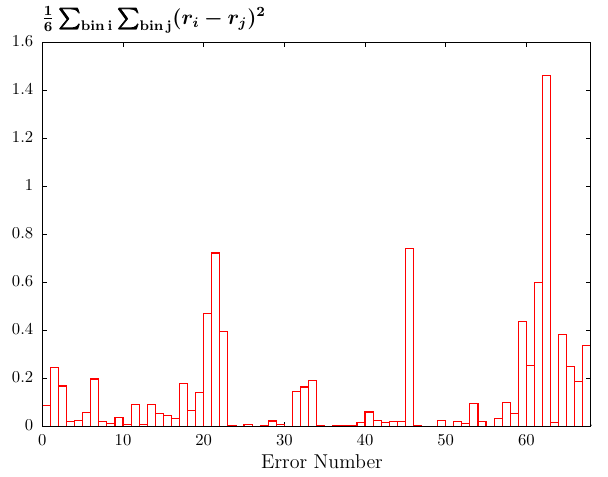
Fig. 3 Average squared sum of the systematic shift differences ( r i − r j ) 2 for the first four rapidity bins of the ATLAS 7 TeV jet data [23]